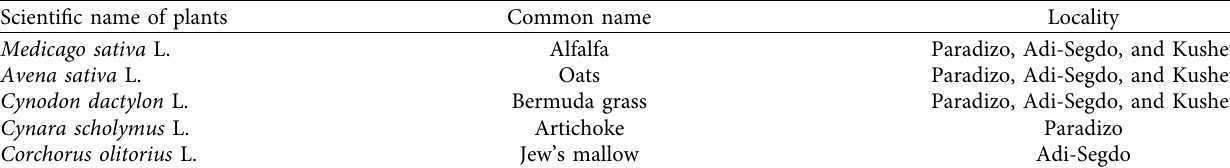
Table 1: The scientific locality of the sample (grasses and